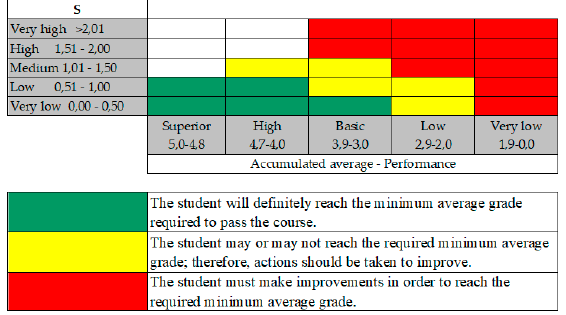
Figure 3. Risk assessment matrix.